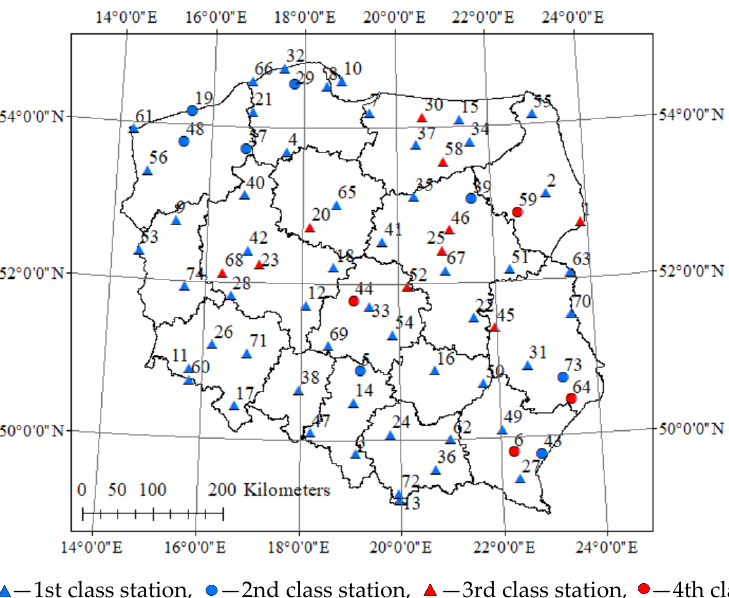
Figure 1. Location of the weather stations considered in the